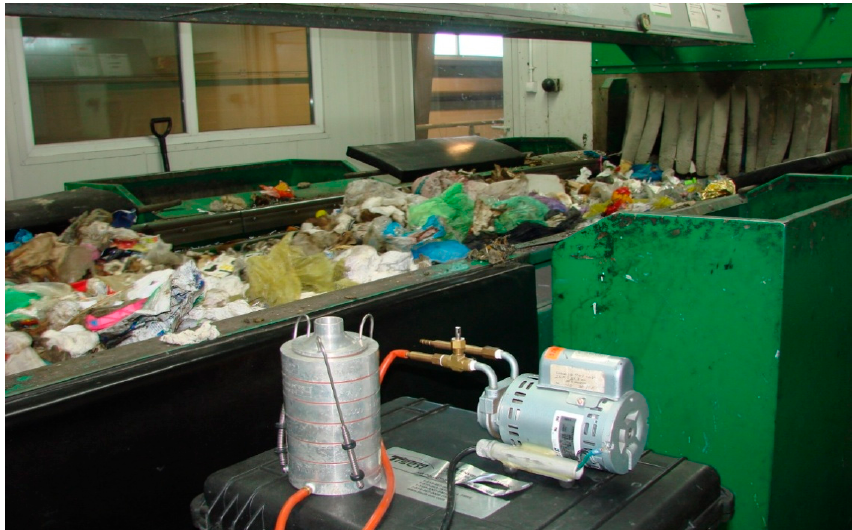
Figure 2. Six-stage Andersen impactor used during measurements in a waste-sorting plant located in Southern Poland.